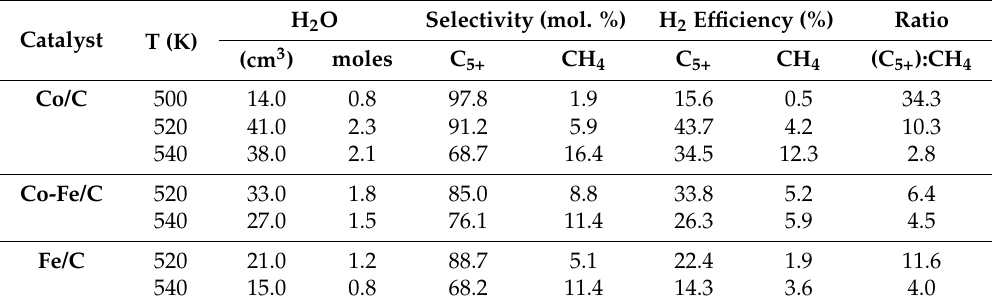
Table 5. The calculated catalysts’ H 2 utilization efficiency at various